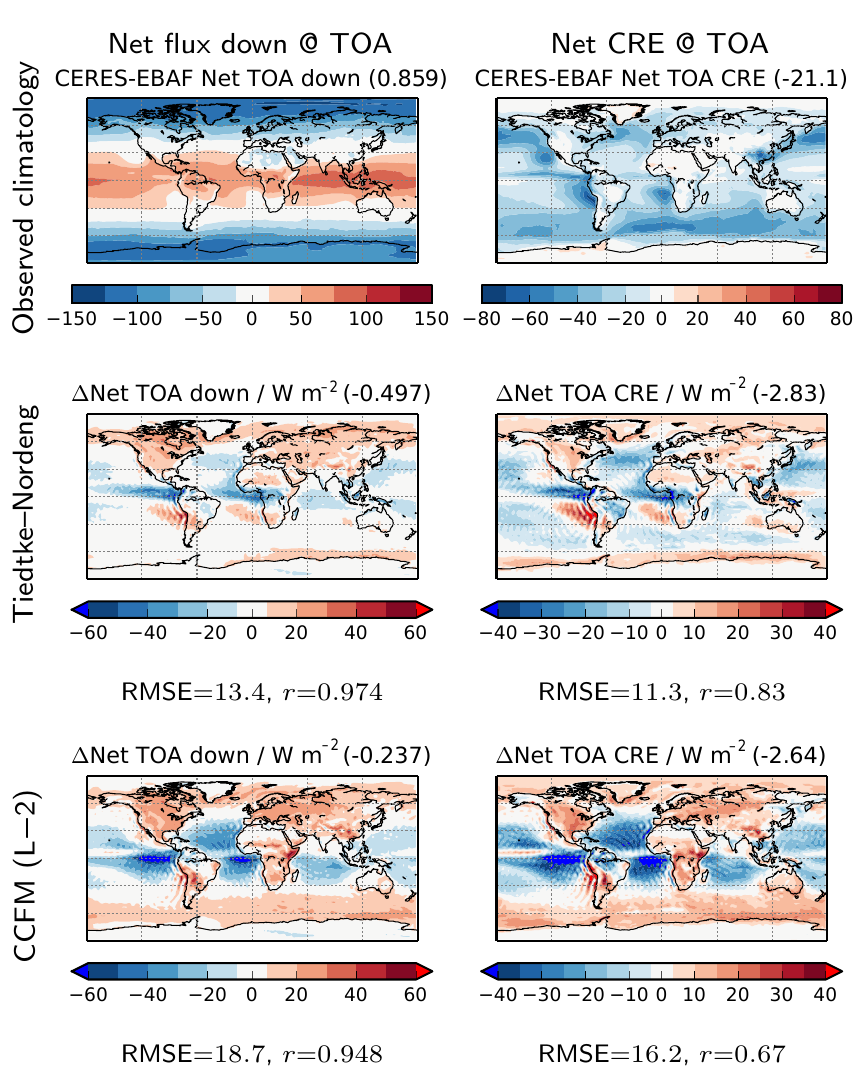
Figure 8. Difference in net downward radiative flux (left) and cloud radiative effect (right) at the top of the atmosphere between 30-year AMIP-type simulations using ECHAM–HAM with Tiedtke–Nordeng and CCFM (L − 2) convection, and a CERES–EBAF